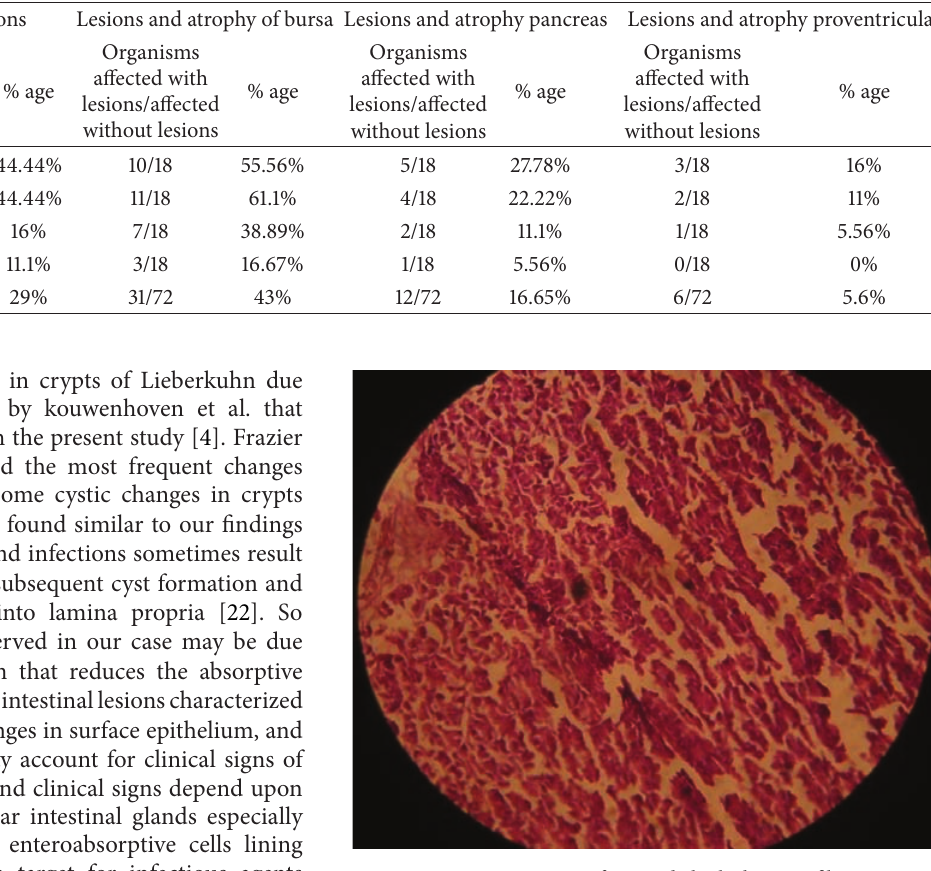
Collectively histopathological pancreatic lesions (16.65%) were found in 1–40-day-old stunted chicks, and bleaching of pancreas (47%) in stunted chicks was observed [14]. RSS affected chicks were characterized by white, firm and thin pancreas, exocrine tissues of which may be lost or replaced by fibrous tissues [15]. These findings were in consistent acini was found damaged. Vacuolation was also noted in some of the pancreatic tissues. Section of affected pancreases exhibited the vacuolation of cytoplasm and loss of